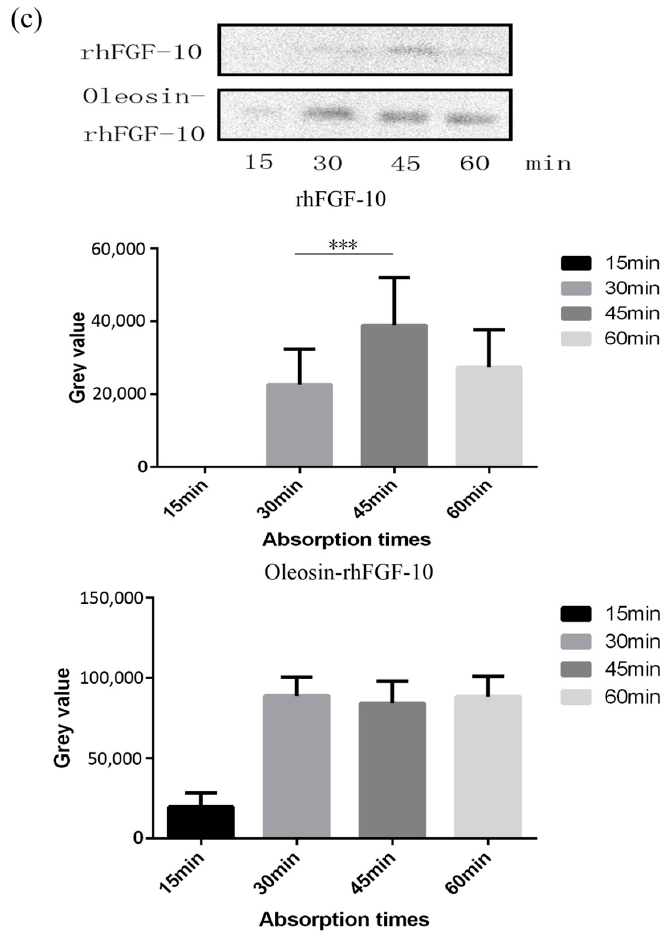
Figure 3. The ability of oleosin-rhFGF-10 to penetrate the skin. ( a ) The effectiveness of drug absorption into skin at different times, as evaluated by photography; ( b ) skin sections were stained for oleosin-rhFGF-10 by immunohistochemistry. The positive protein is stained brown and is marked by the black boxes; ( c ) the western blotting quantification method for objective evaluation in skin. The images are shown at 400× magnification. *** p < 0.001.